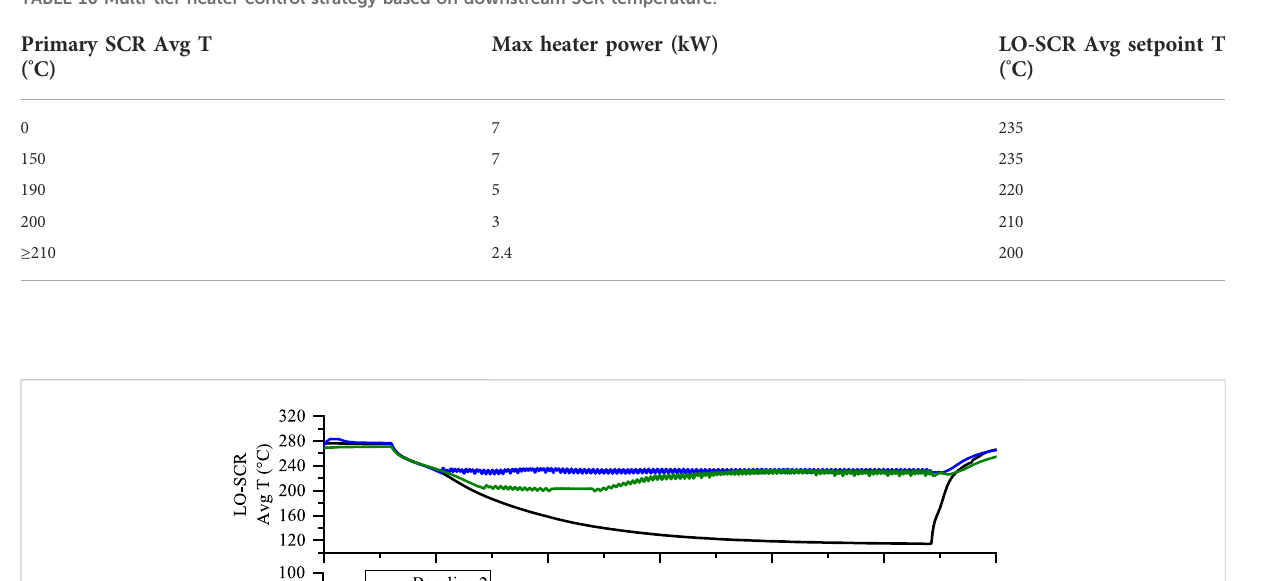
TABLE 10 Multi-tier heater control strategy based on downstream SCR temperature.